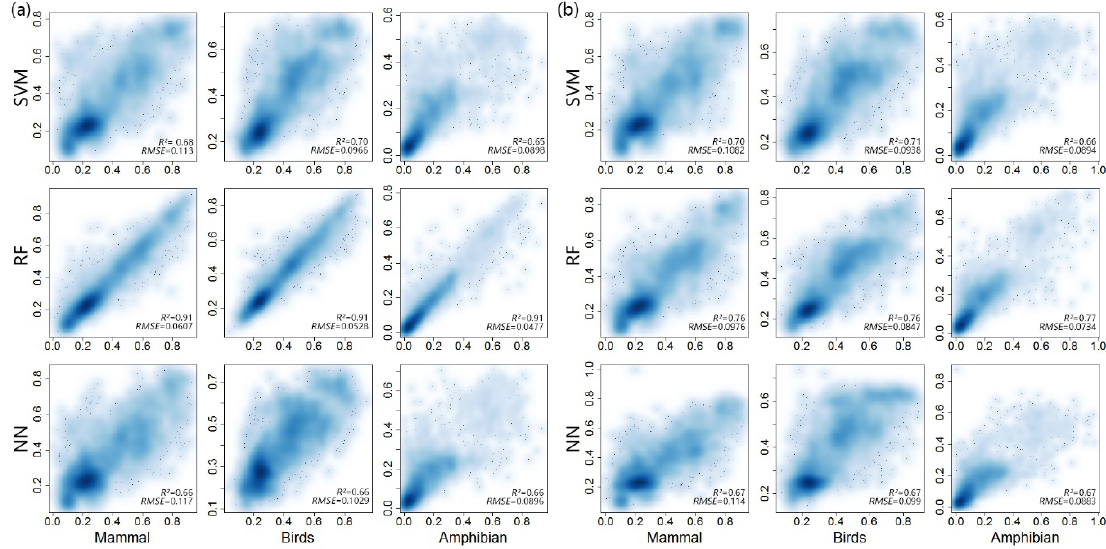
Figure 7. The correlation between predicted species richness and in situ species richness. ( a ) training dataset, ( b ) prediction dataset. The measured values were obtained for 10,000 0.1-degree pixels randomly selected from terrestrial areas of the globe, and 5000 pixels were randomly selected for training and prediction separately.